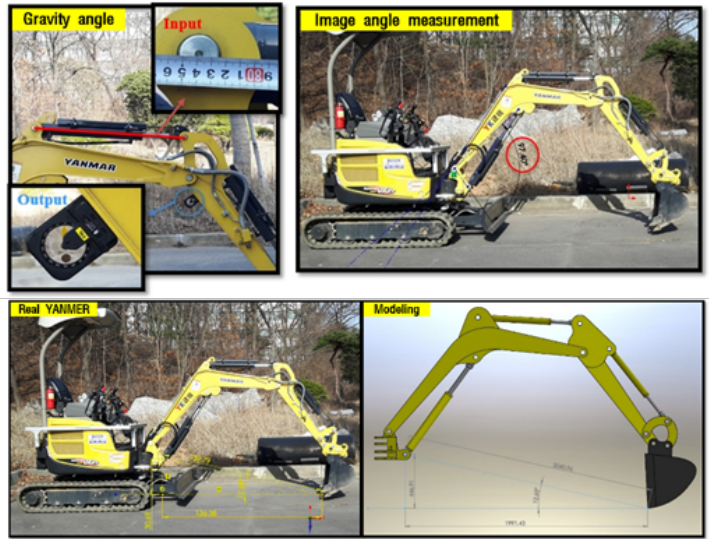
Figure 4. The illustration of the measurement methods: protractor and imagery.